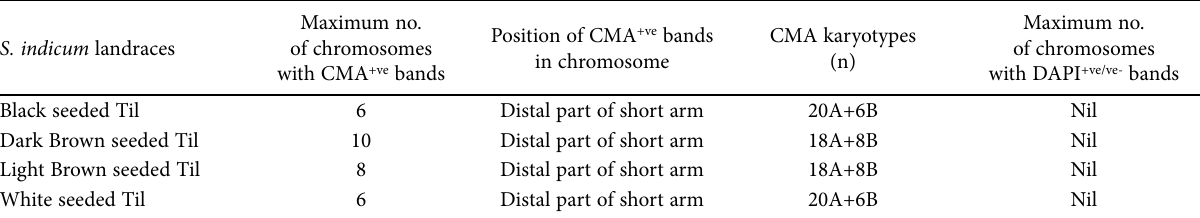
Table 3. Fluorescent banding patterns in four Indian landraces of S.